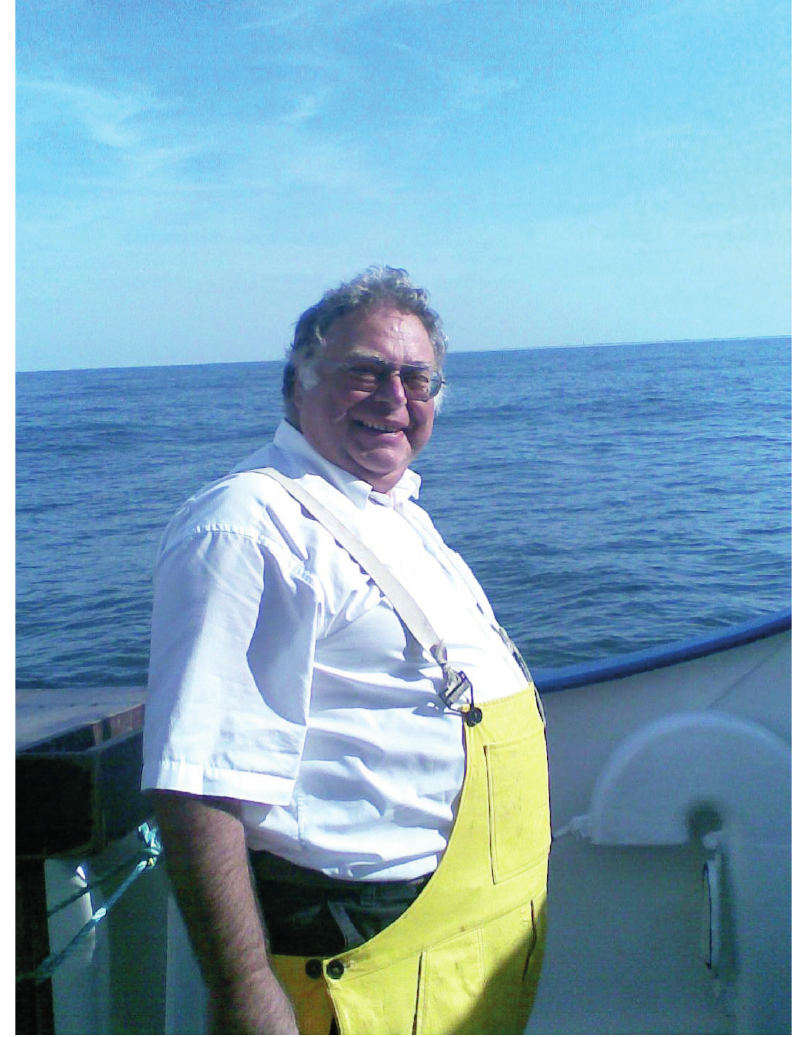
Figure 1. Michael Türkay on board of the RV Senckenberg in the North Sea, 1 st August 2007 Photo: Moritz